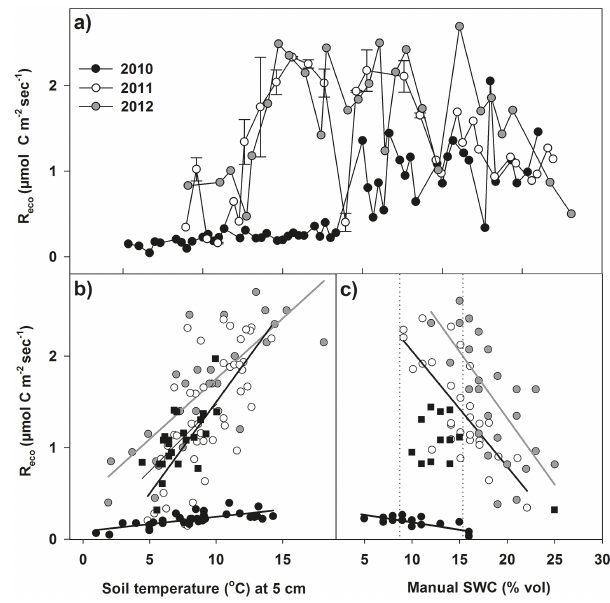
Figure 2. Seasonal patterns and correlations of ecosystem respi- ration ( R eco ) , soil water content (SWC) and soil temperature un- der control conditions (average ± SE, n = 1 − 3 plots) during the summers of 2010–2012: (a) daily R eco flux, b) correlation between daily R eco flux and soil temperature at 5cm in depth measured manually during the flux measurement, and (c) correlation between daily R eco flux and SWC at 5cm in depth measured manually dur- ing the flux measurement. (In (b) and (c) , black circles indicate the early, dry period. Black squares indicate the late, wet period of the summer of